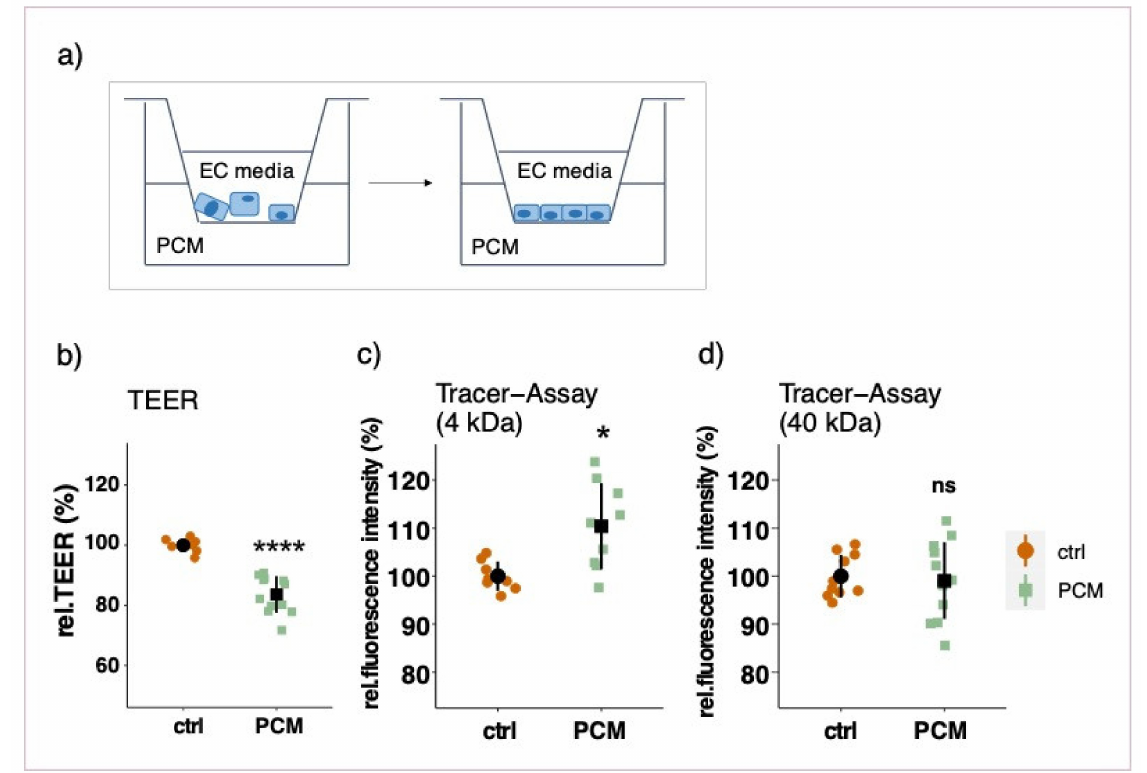
Figure 4. Measurements of endothelial barrier function after prolonged basolateral PCM treatment. Endothelial cells (ECs) were plated on transwell inserts with EC growing media in the apical chamber and PCM in the basolateral chamber ( a ). Relative TEER measurements ( b ) and macromolecular tracer assays with FITC-labeled dextran of 4 and 40 kDa ( c , d ) were performed after 7 days in culture. Measurements were performed at least three times in triplicates and data represent mean ± sd. ns p > 0.05, * p < 0.05, **** p <